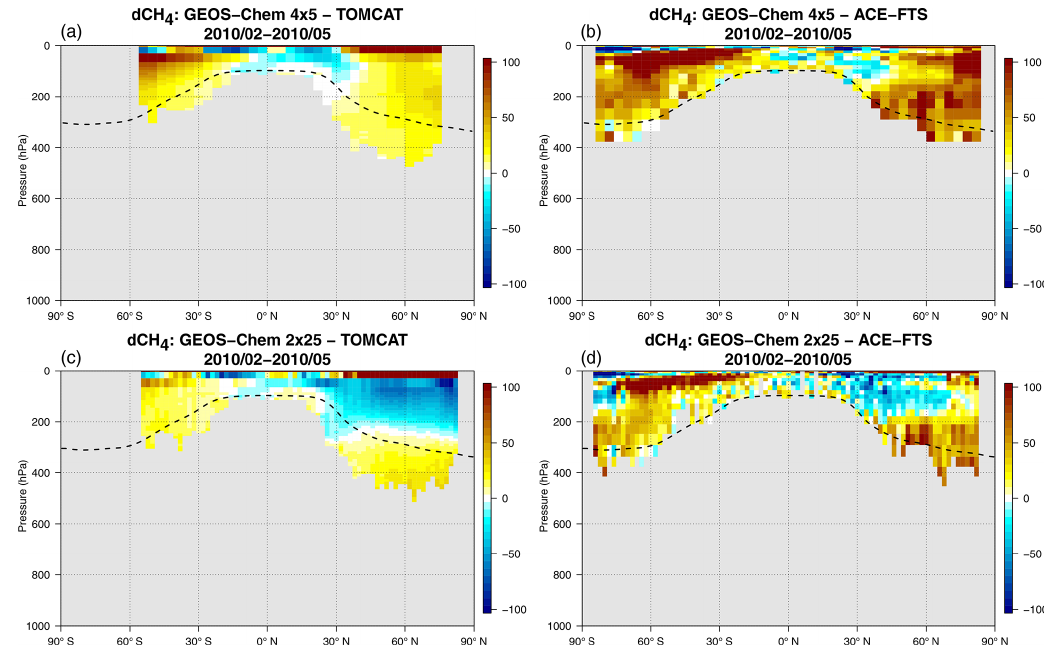
Figure 2. Zonal mean CH 4 differences (median value for the period of February–May 2010) in the stratosphere between GEOS-Chem at 4 ◦ × 5 ◦ and the GOSAT CH 4 a priori fields (a) , GEOS-Chem at 4 ◦ × 5 ◦ and ACE-FTS CH 4 retrievals (b) , GEOS-Chem at 2 ◦ × 2 . 5 ◦ and the GOSAT CH 4 a priori fields (c) , and GEOS-Chem at 2 ◦ × 2 . 5 ◦ and ACE-FTS CH 4 retrievals (d) . The dashed line represents the mean dynamic tropopause averaged over February–May 2010 from the archived GEOS-5 meteorological